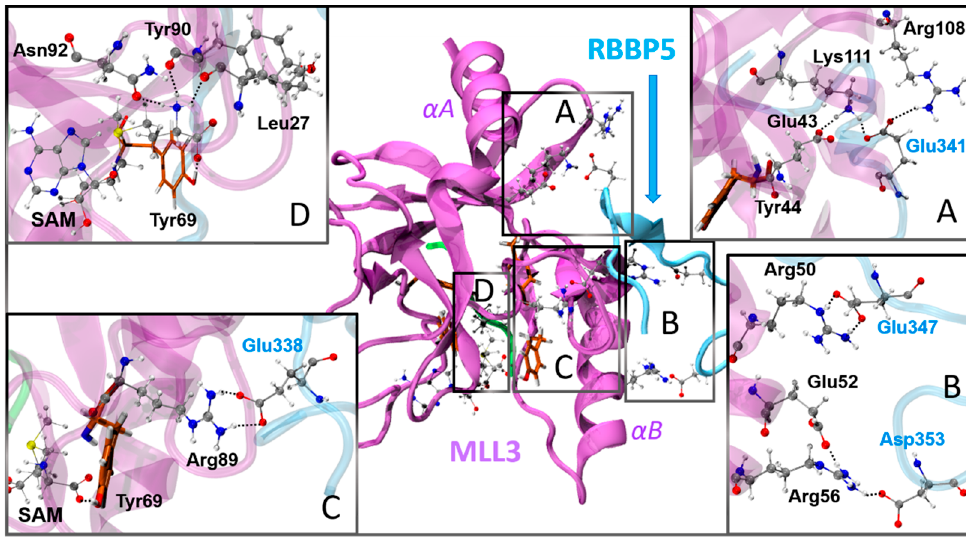
Figure 8. Graphical representation of the main salt-bridge interactions between MLL3 and RBBP5. There are four regions of the enzyme identified as possibly involved in the activation mechanism of MLL3 enzyme and these are enclosed in boxes ( A – D ). The coloring of the tertiary structure of MLL3 and RBBP5 are purple and light-blue, respectively (atom coloring: tyrosine’s carbon-orange; rest of the carbon’s ― gray; red ― oxygen; blue ― nitrogen; white ― hydrogen).